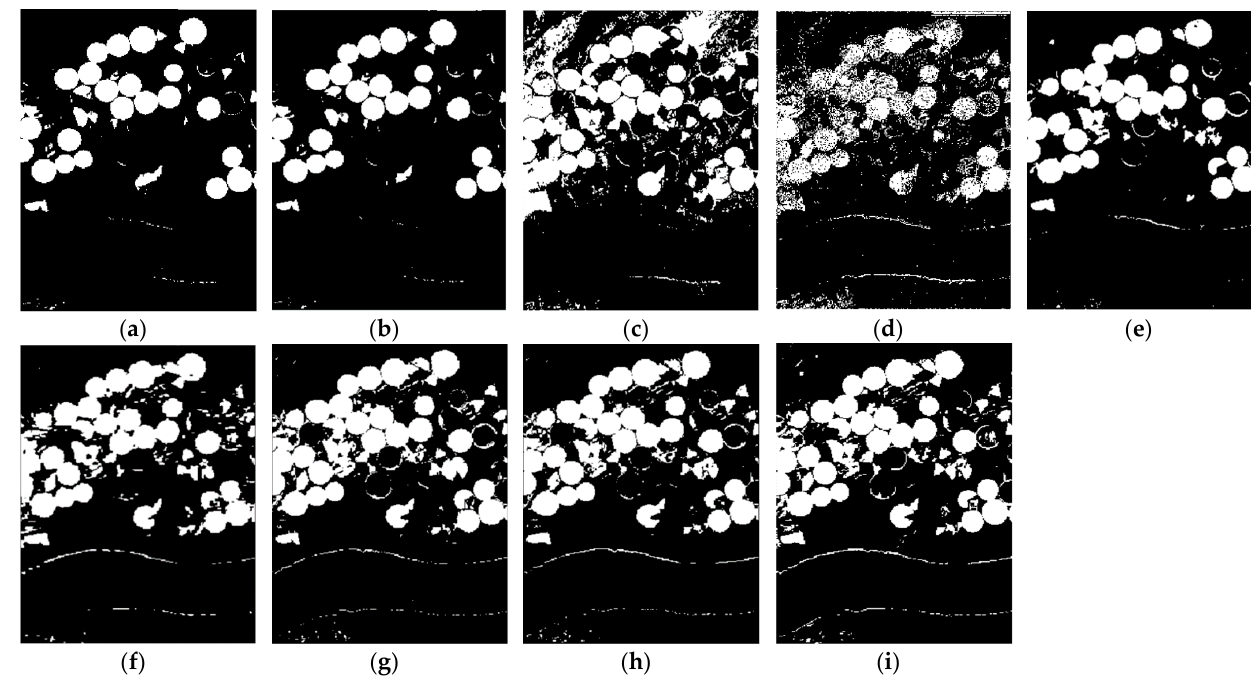
Figure 5. CD result on River. ( a ) CVA [14] ( b ) PCACVA [25] ( c ) SVM [19] ( d ) PBCNN [56] ( e ) GET-